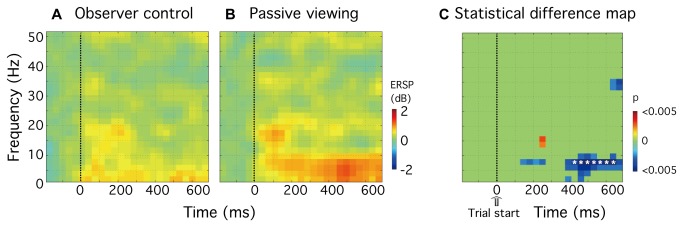
Group analysis (n=10) showing the self-monitoring related oscillatory activity for the time-locked-to-start data set in rCMA.
A and B, The group-mean ERSP plots show power differences (in dB) referenced to a 300 msec baseline recording for (A) observer-control and (B) passive viewing conditions. C, Statistical significance map of the differences between the experimental conditions, as assessed using a paired-sample t test (n = 10, p < 0.05). Multiple comparisons were corrected for 7.8 Hz to 13.7 Hz, and results are indicated as white asterisks in Panel C (p < 0.05, FDR corrected; df = 9).